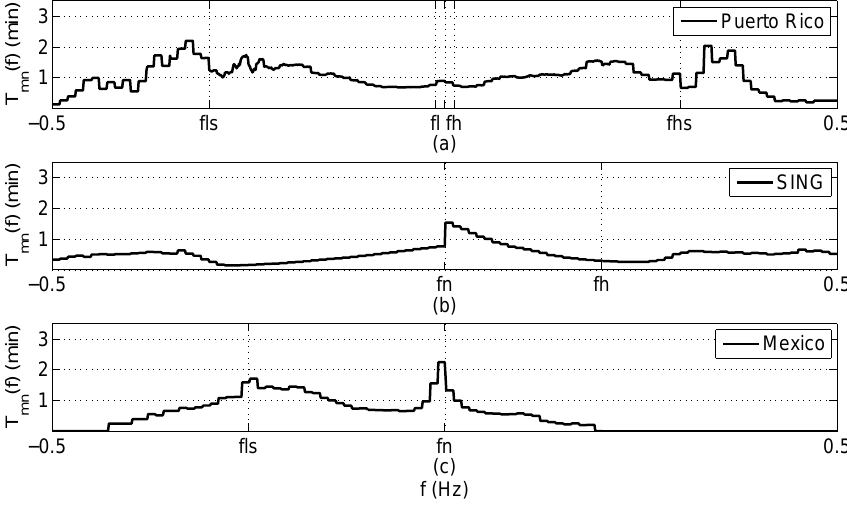
Figure 8. Mean clearing time of frequency excursions in three different power grids: ( a ) Puerto Rico (PREPA); ( b ) Chile (SING); and ( c ) Mexico